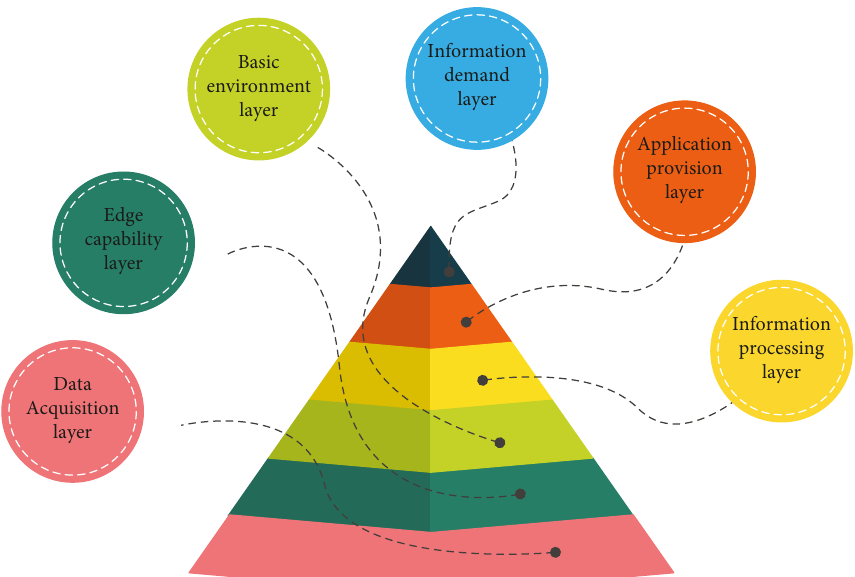
Figure 2: The new smart city system architecture based on edge computing.